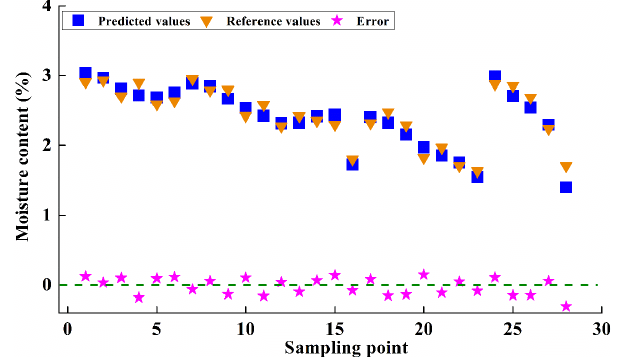
Fig. 7. Monitoring results of in-line quantitative model of water